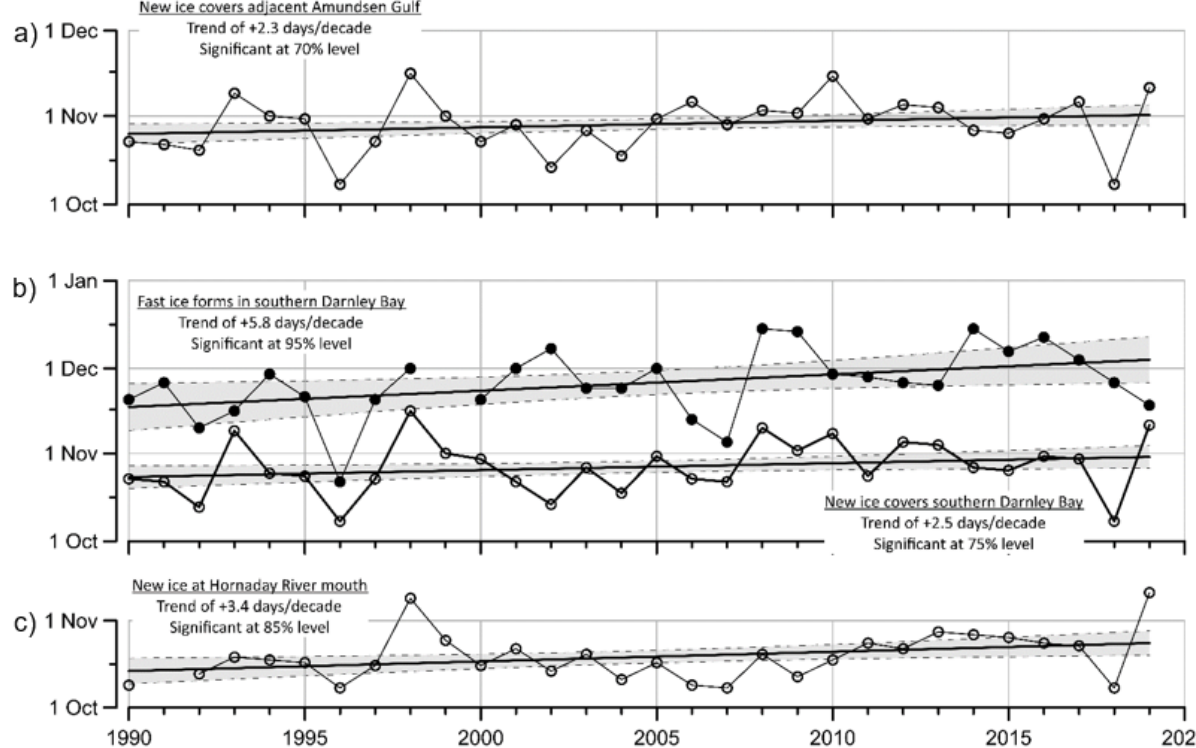
Figure 10. Timing of ice freeze-up from 1990 to 2019 in a) Amundsen Gulf, b) southern Darnley Bay, and c) mouth of the Hornaday River. Figure provided by H.